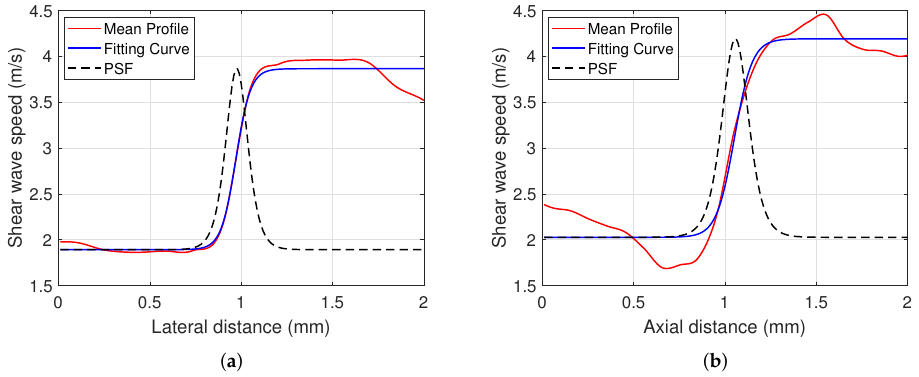
Figure 5. Axial and lateral resolution determination for mechanical wave elastography. ( a ) Lateral direction and ( b ) axial